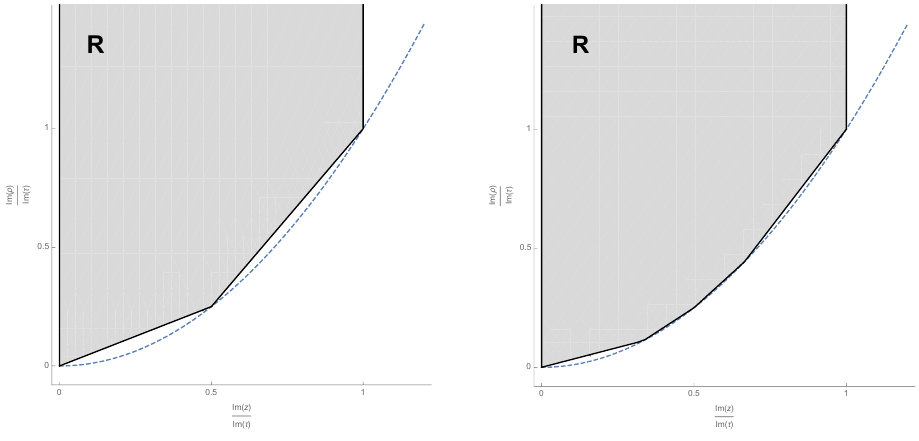
Figure 2 . These plots show the chamber R for t = 2 (left) and t = 3 (right). The dashed line corresponds to the boundary of the Siegel upper half plane; the region R is always enclosed between the lines Im z = 0 and Im z = Im (cid:28) for any t . But the number of lines bounding R from below depends on t : the relevant lines shown here are those in (4.17) and (4.18).